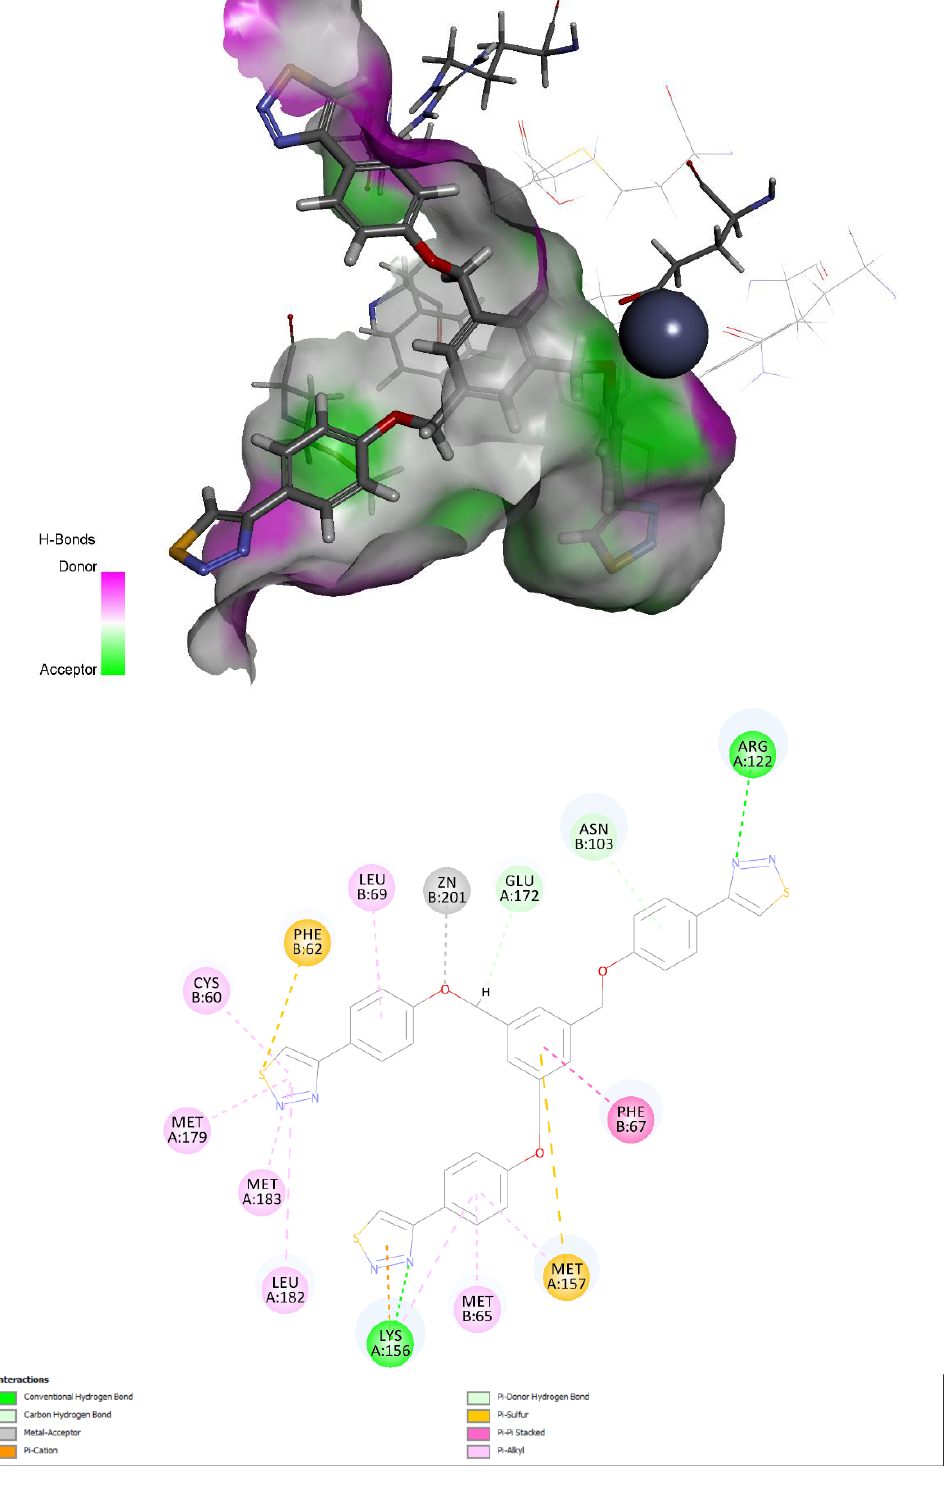
Figure 2. A docked pose of compound 8 with an IC 50 = 3.0 µM inside the actives site. A three-dimensional representation of compound 8 showing its fitting inside the active site (Top). A two dimensional diagram showing the most important interactions with the active site amino acids: green, conventional hydrogen bond; sky blue, carbon hydrogen bond; grey, metal acceptor; orange, Pi-Carbon; light orange, pi-sulfur; purple, pi-pi stacked; light purple, pi-alkyl. (Bottom).